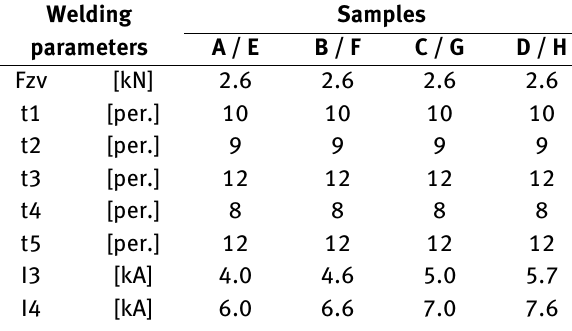
Table 3: Welding parameters for steel sheets (A, B, C, D – H220 LAD), (E, F,G, H – H340